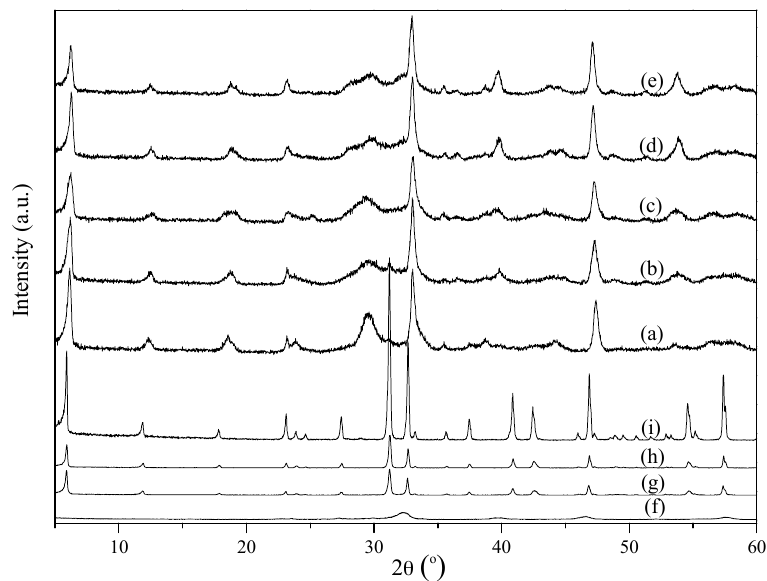
Figure 3. XRD patterns of and Cu 2+ /K 2 La 2 Ti 3 O 10 calcined at 300 °C ( a ), 400 °C ( b ), 500 °C ( c ), 600 °C ( d ), 700 °C ( e ); and original K 2 La 2 Ti 3 O 10 calcined at 650 °C ( f ), 750 °C ( g ), 850 °C ( h ), 950 °C ( i ). Table 1. Grain size, specific surface area, and chlorobenzene degradation ratio of Cu 2+ /K 2 La 2 Ti 3 O 10 at different calcination temperatures and original K 2 La 2 Ti 3 O 10 in air.